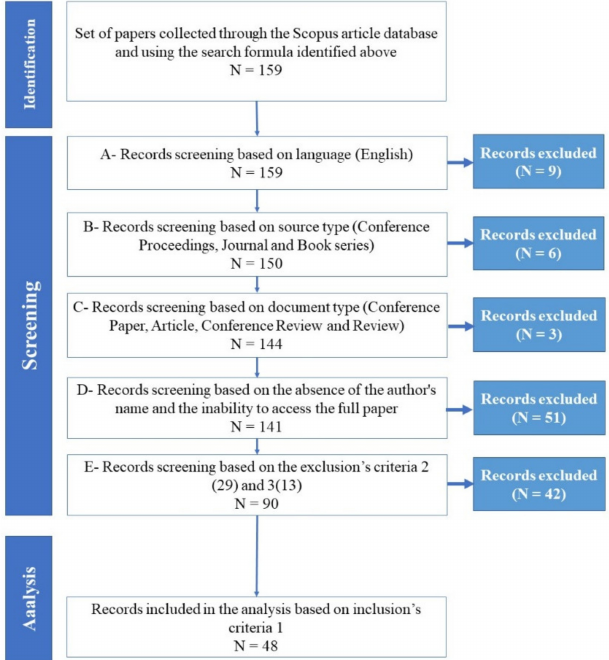
Figure 2. PRISMA scheme of articles’